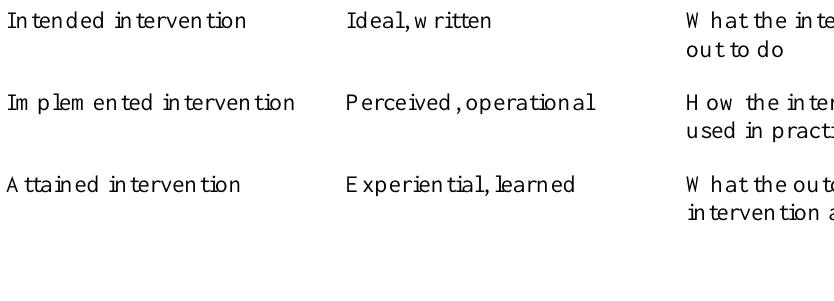
Three Forms of an Intervention (adapted from van den Akker, 2003, p. 3) Intended intervention Ideal, written What the intervention sets Implemented intervention Perceived, operational How the intervention is Attained intervention Experiential, learned What the outcomes of the